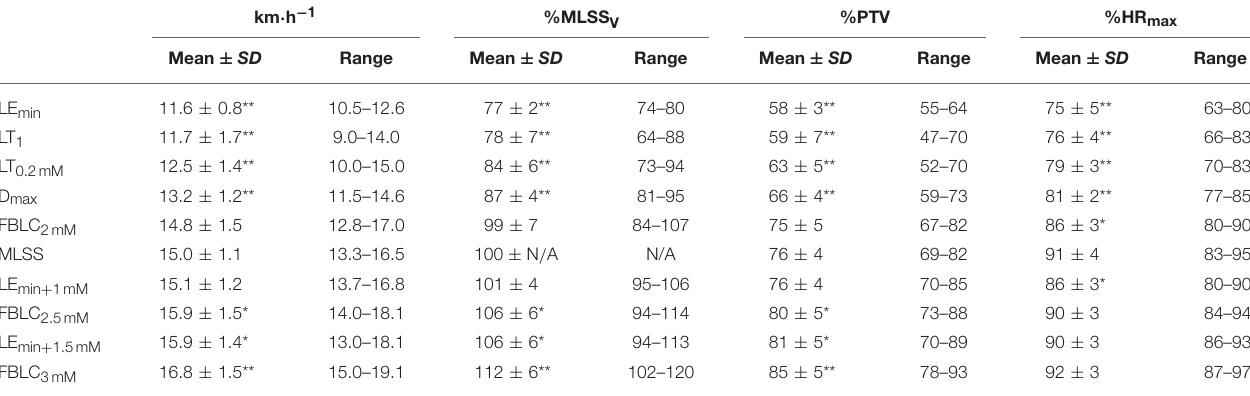
TABLE 1 | Descriptive features of the determined blood lactate-related thresholds and maximal lactate steady state (MLSS) ( n = 13).